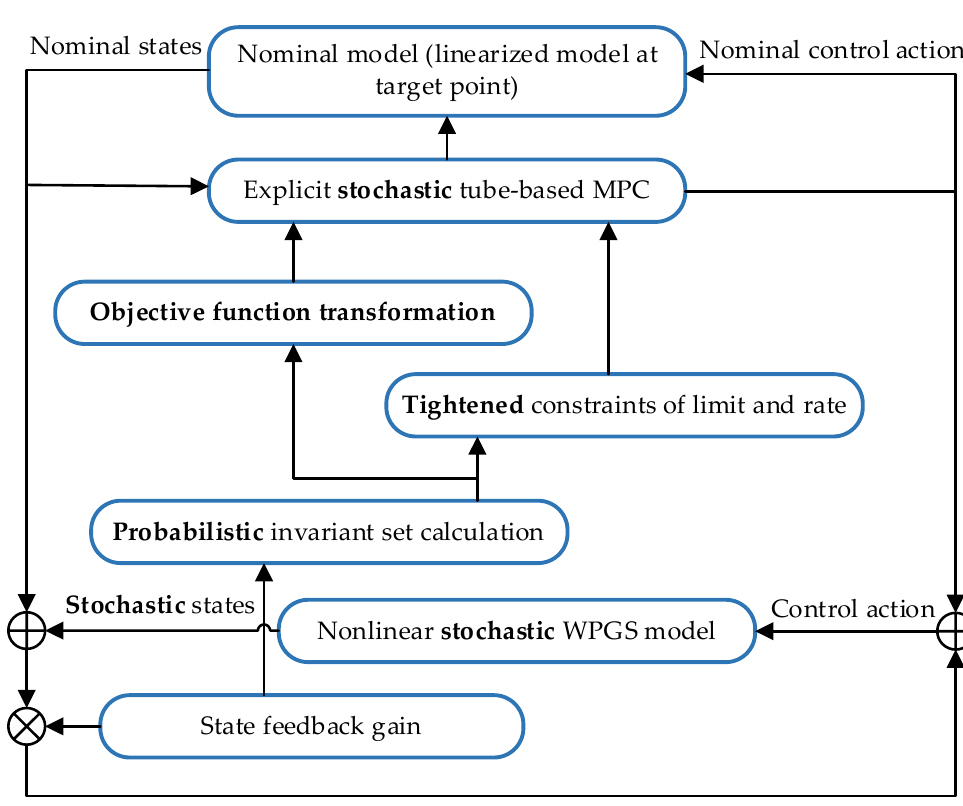
Figure 3. Stochastic MPC for WPGS.